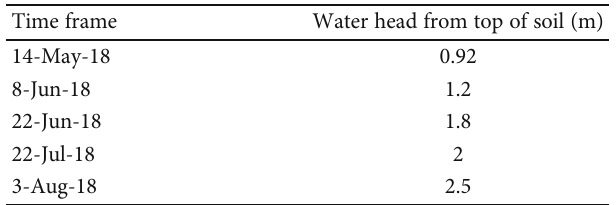
Table 3: Calculation of E for di ff erent layers of plastic brown and sensitive blue